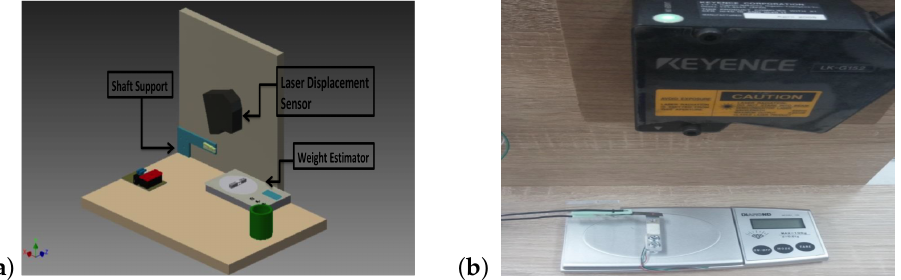
Figure 3. Designed measuring test stand front view ( a ) and measurement conducted with a laser transducer ( b